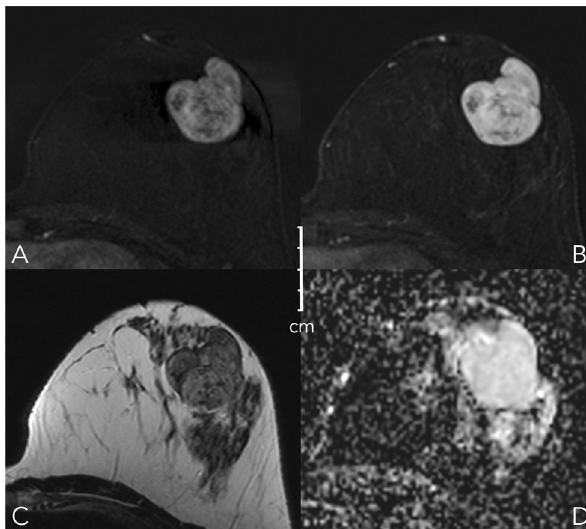
Fig. 8 Early (A) and delayed (B) contrast-enhanced subtractions, T2w (C), and ADC map (D). Mass lesion in the left breast of a 27-year-old female, newly palpable after considerable weight loss. The lesion shows no spiculations, a persistent enhancement curve type, and circumscribed margins, corresponding to a Kaiser score of 1 (Fig. 6). Note internal septations and high ADC (2.1*10 -3 mm 2 /s). This is an unambiguous benign finding, BI-RADS 2. The patient requested a biopsy that revealed a fibroadenoma B2